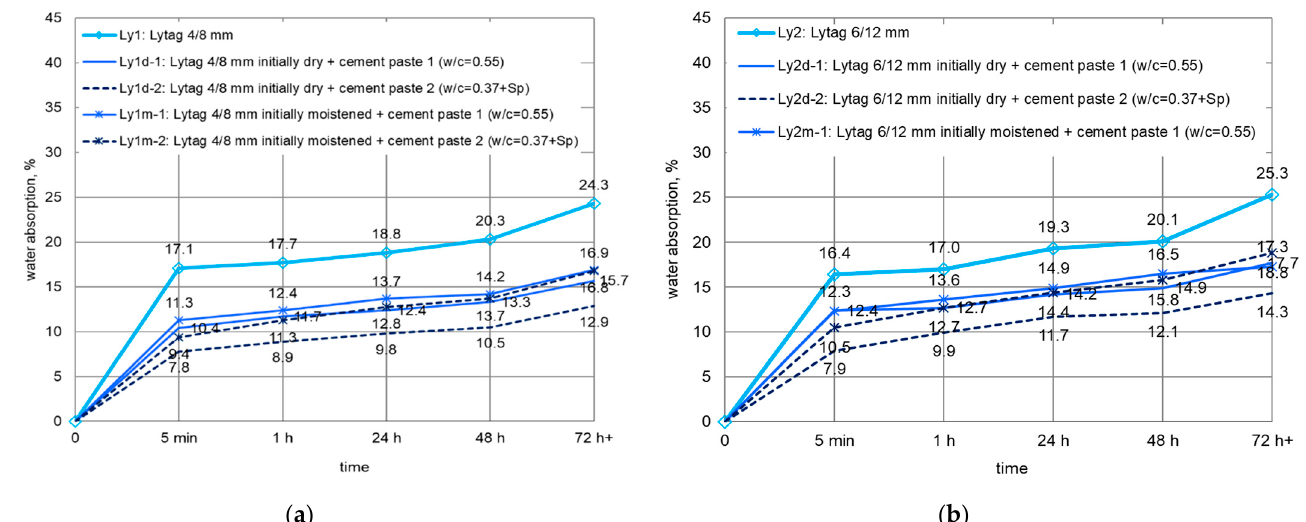
Figure 8. Development of water absorption in time for Lytag aggregate impregnated with cement pastes: ( a ) Lytag 4/8 mm, ( b ) Lytag 6/12 mm.